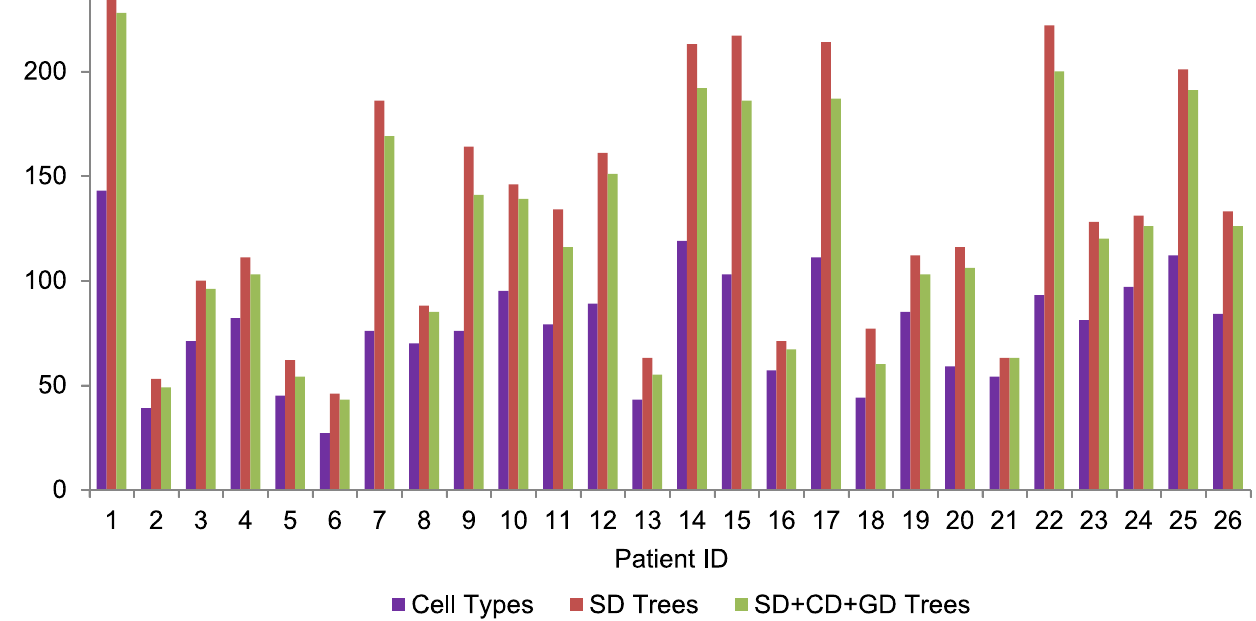
Figure 6. Parsimony score comparison on the BC samples. Comparison of DCIS (id 1–13) and IDC (id 14–26) BC tumor progression tree weights built considering only SD and combined SD, CD and GD models. ‘‘Cell Types’’ refers to the total number of unique probe copy number configurations in the dataset, providing a lower bound on the minimum possible parsimony score for a given data set.